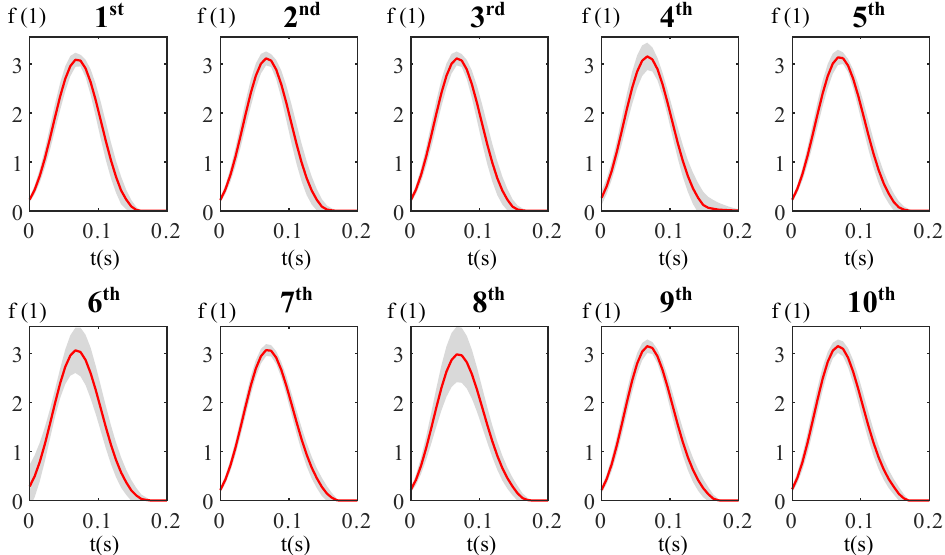
Figure 5. The maximum normalized ground reaction force’s impulses during cross landing in the case of Dancer No. 2. For each 30 s-long dancing session, the measured force impulses are plotted on top of each other. The red GRF impulse curve denotes the mean curve in each session. Note that in the statistical analyses, only the maximum peak value was used. The numeric data are detailed in Supplementary Material